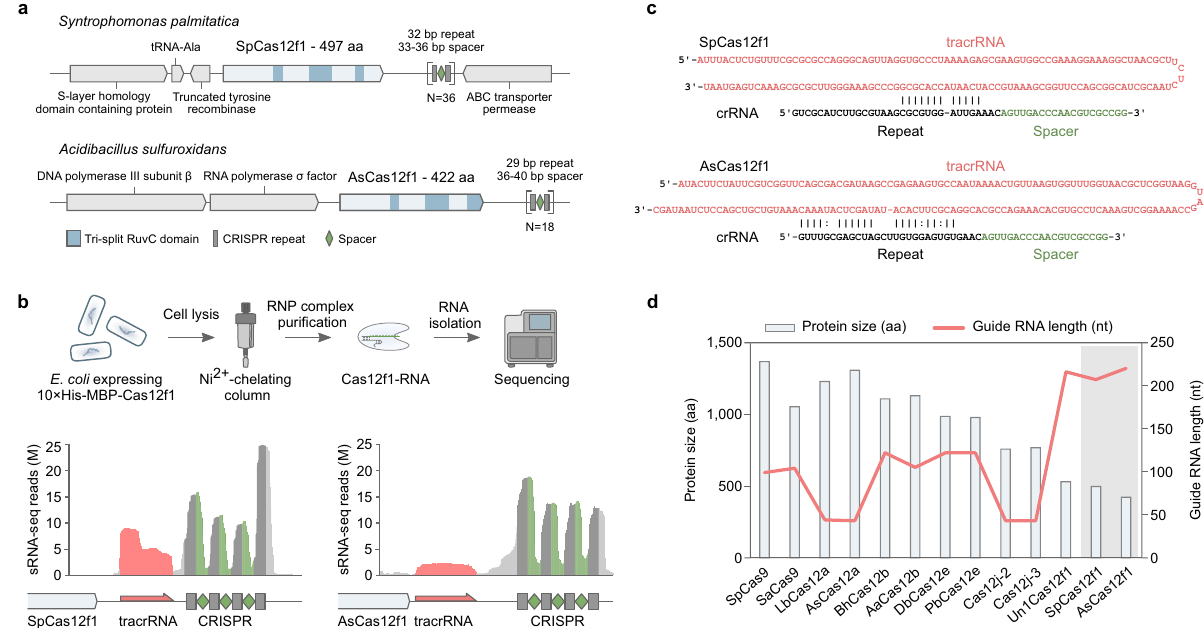
Fig. 1 SpCas12f1 and AsCas12f1 CRISPR-Cas loci and effector complex components. a Schematic representation of native CRISPR-Cas loci encoding SpCas12f1 and AsCas12f1 effector proteins. b Work fl ow of the biochemical approach used to isolate and identify Cas12f1 RNP-bound RNA molecules. c In silico prediction of base pairing between identi fi ed tracrRNA and crRNA sequences. d Size comparison (aa) of Cas effector proteins (bars) and respective guide RNA length (red line) (nt) with SpCas12f1 and AsCas12f1 nucleases highlighted in the gray